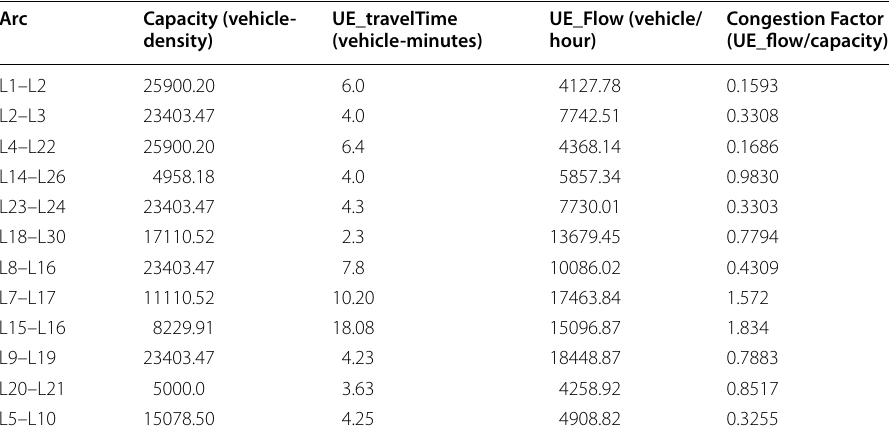
Table 3 User Equilibrium traffic flow and congestion index for 24-Node transportation network